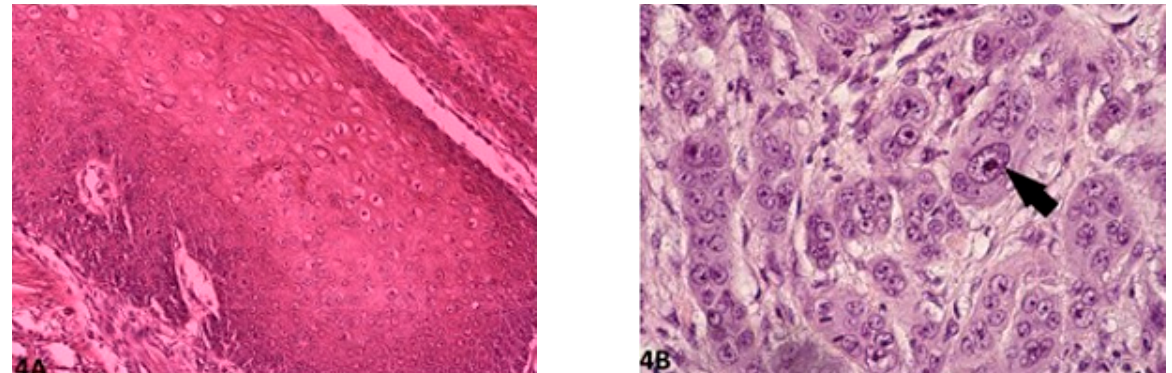
Figure 4. Nuclear pleomorphism: ( A ) (O.M. 8 × ): Mild/minimal pleomorphism in <25% neoplastic cells (Golden Retriever, No. 87); ( B ) (O.M. 40 × ): Extreme nuclear pleomorphism with intense nuclear atypia (arrow), accounting for more than 75% of neoplastic cells (Giant Schnauzer, No. 56). O.M: original magnification.